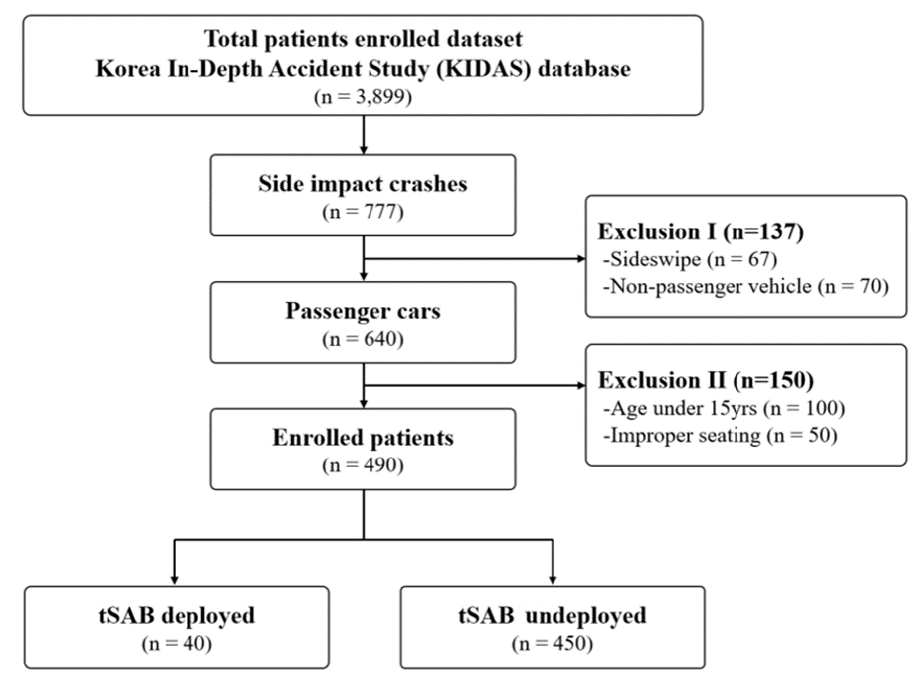
Figure 1. Flowchart of study participants. KIDAS; Korea In-Depth Accident Study, tSAB; thoracic side